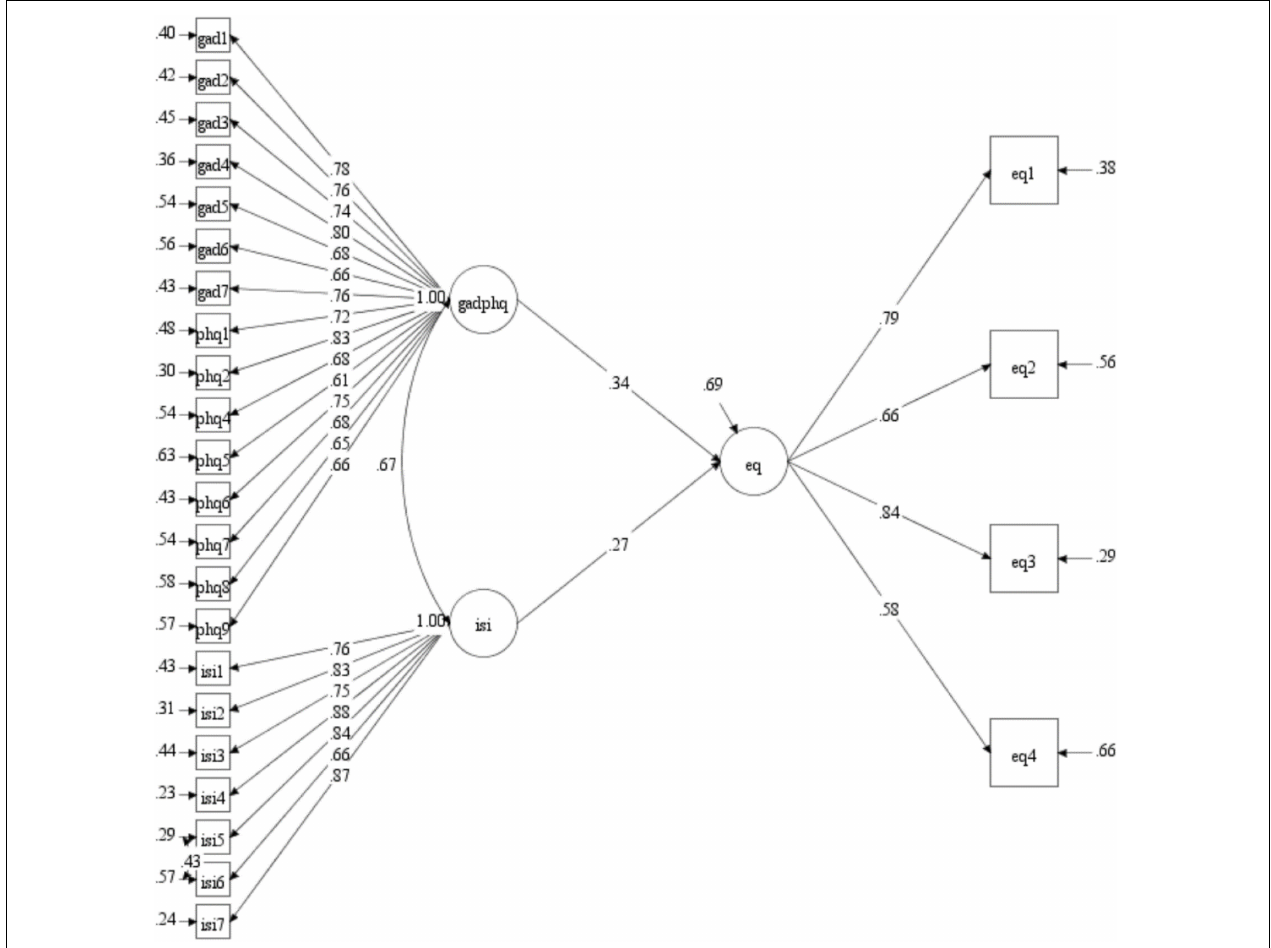
FIGURE 1 | The SEM analysis with PHQ-ADS and ISI predicting health-related quality of